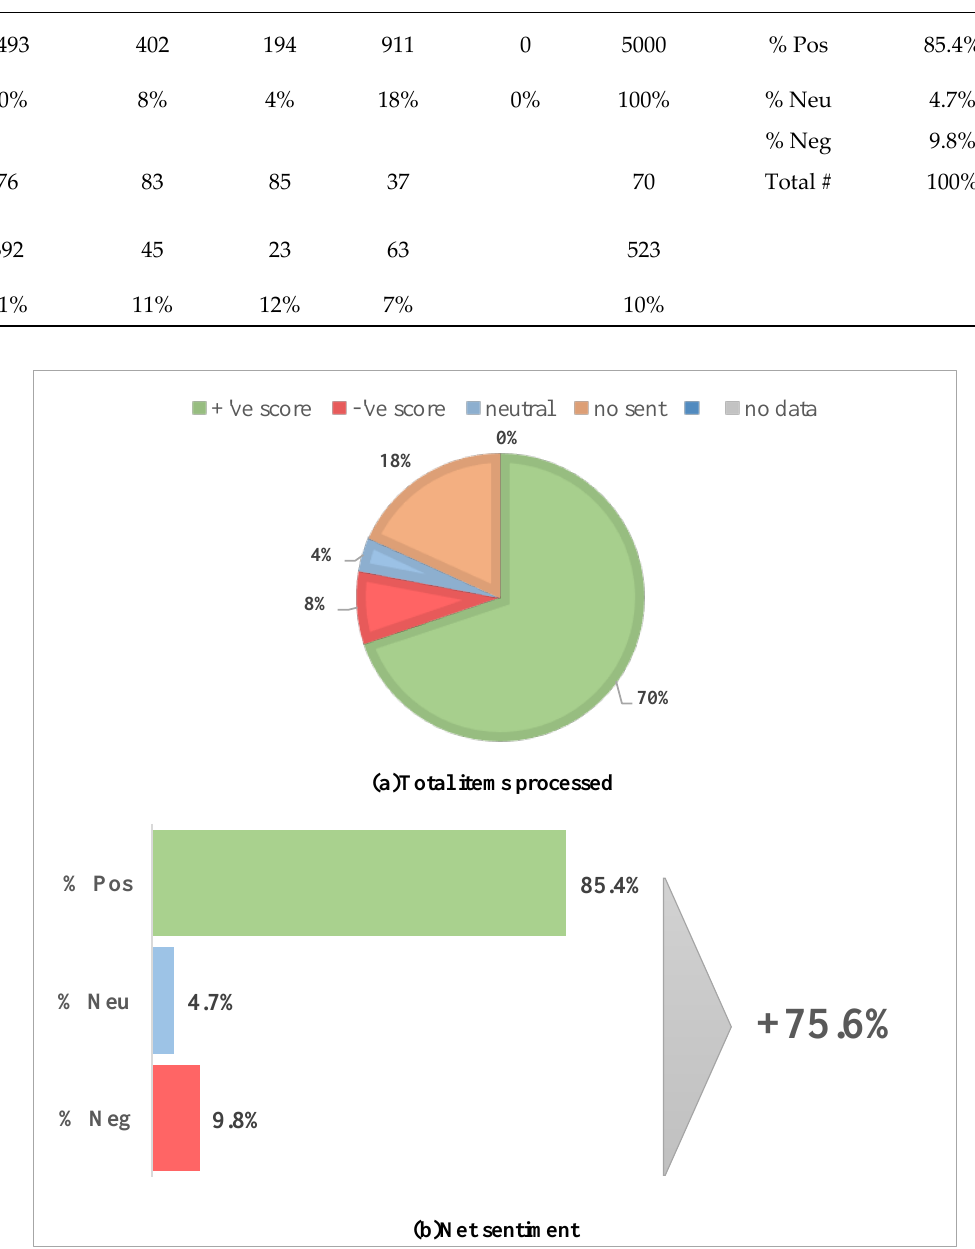
Figure 5. Total items processed and net sentiment. Note: Pos means positive, Neu means neutral, and Neg means negative.